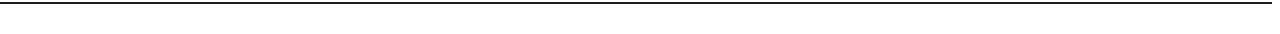
Fig. 2 Disrupting circBIRC6 or circCORO1C impairs hESC pluripotency. a The schematic illustrates how circular junction sites were targeted for circRNA- speci fi c shRNAs (shcircRNAs). The schematic also shows the targeted regions for RT-qPCR primers. Divergent primers were used for circRNAs and convergent primers for the linear isoforms. b – d Total RNA isolated from hESCs transfected with shcircB, shcircC, shcircMa, or paired control virus 3 days post transduction was analyzed by RT-qPCR to determine the expression levels of b circBIRC6 (circB), circCORO1C (circC), circMAN1A2 (circMa), and their linear counterparts (LinB, LinC, and LinMa), and the indicated c pluripotency-associated genes and d lineage-associated genes. e AP staining of shcircB, shcircC, and shcircMa-transduced H9 hESCs. Scale bar: 200 μ m. f ICC analysis of shcircB, shcircC, or shcircMa-transduced H9 hESCs 3 days post virus infection using antibodies against the pluripotency and lineage markers as indicated. The corresponding bar graphs show quantitative analysis of the percentage of cells expressing pluripotency-associated markers or lineage-associated markers. Scale bar: 20 μ m. g ICC and quantitative comparison of NANOG and OCT4 expression between shcircB-transduced and shcircC-transduced hESCs and their counterparts rescued by overexpression of circBIRC6 (H9-shcircB-res) or circCORO1C (H9-shcircC-res). Nuclei were stained with DAPI (blue). Scale bar: 20 μ m. h RT-qPCR analysis of the expression of the indicated pluripotency-associated genes in shcircB-transduced or shcircC-transduced H9 hESCs and their rescued counterparts, H9-shcircB-res and H9- shcircC-res. Quantitative data from three independent experiments is presented as mean ± SD (error bars). P -values were determined by two-tailed two- sample t -tests (* P < 0.05; ** P < 0.01; *** P <